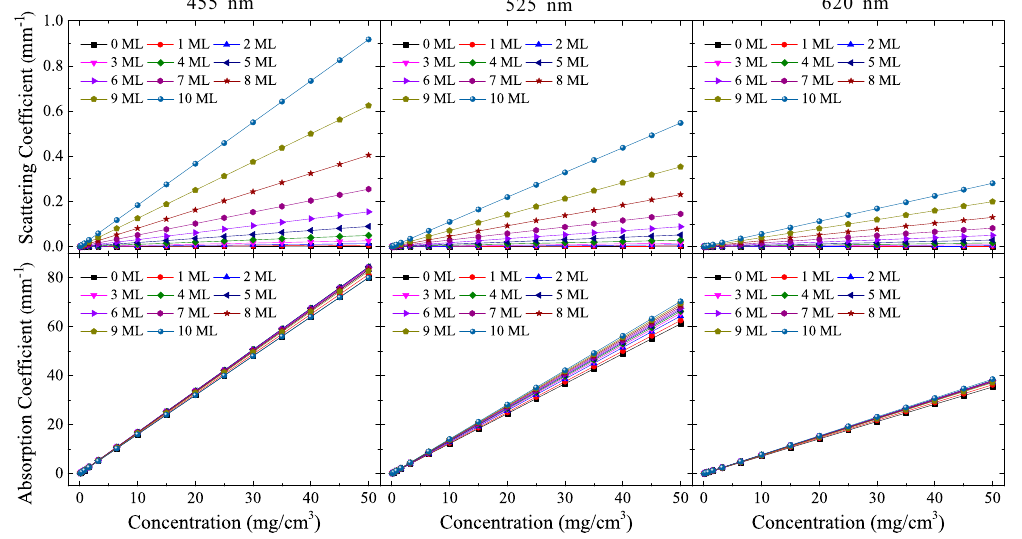
Figure 3. Scattering and absorption coefficients of quantum-dot-converted elements (QDCEs) with